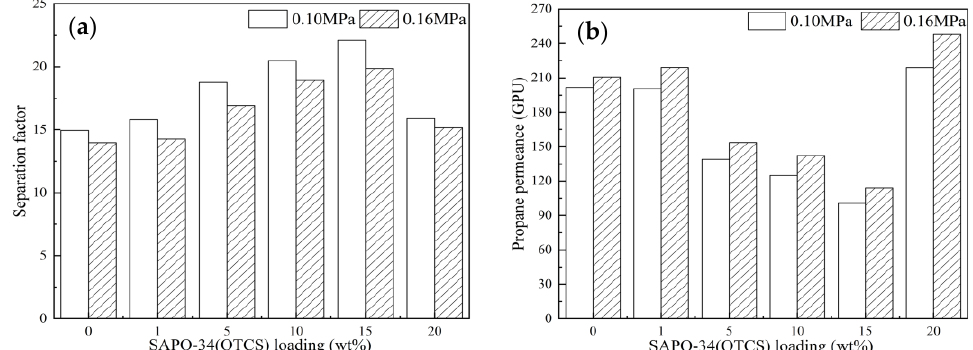
Figure 9. Effects of operating pressures of different SAPO-34 (OTCS) loading of membranes on separation factors ( a ) and propane permeance ( b ) in propane concentration of 20 vol%.